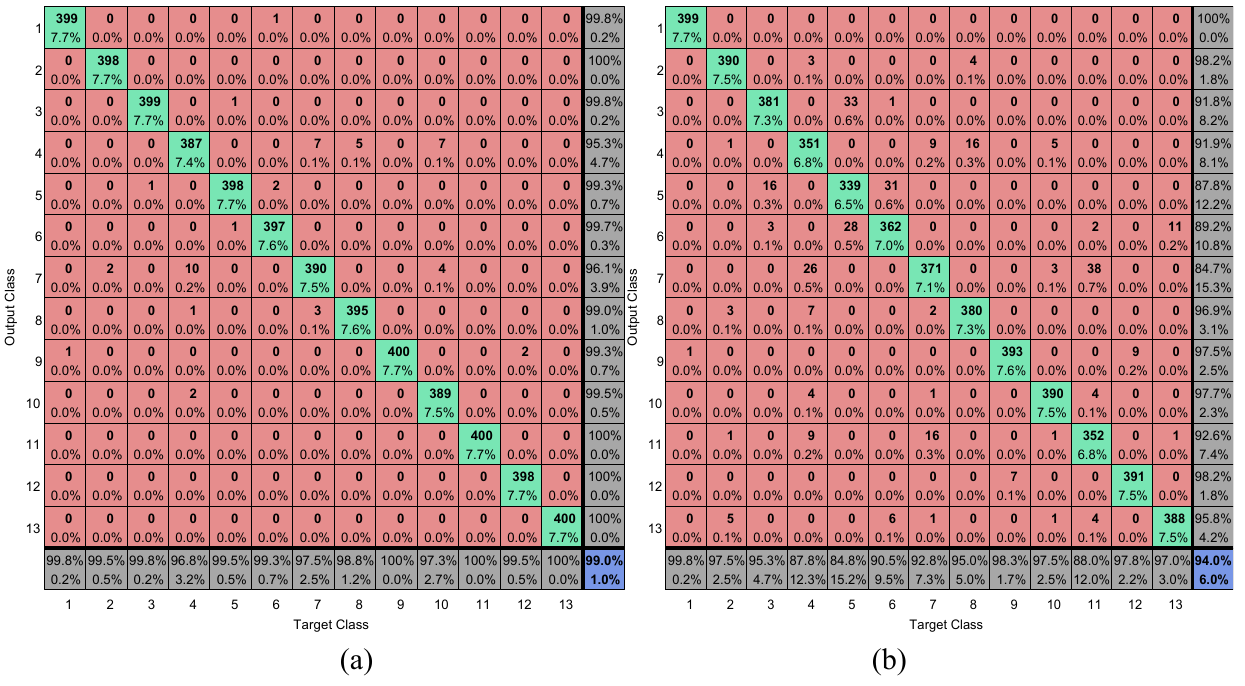
Figure 16. Confusion Matrixes of ACPSO-NN algorithm. ( a ) Training Area; ( b ) Test Area.